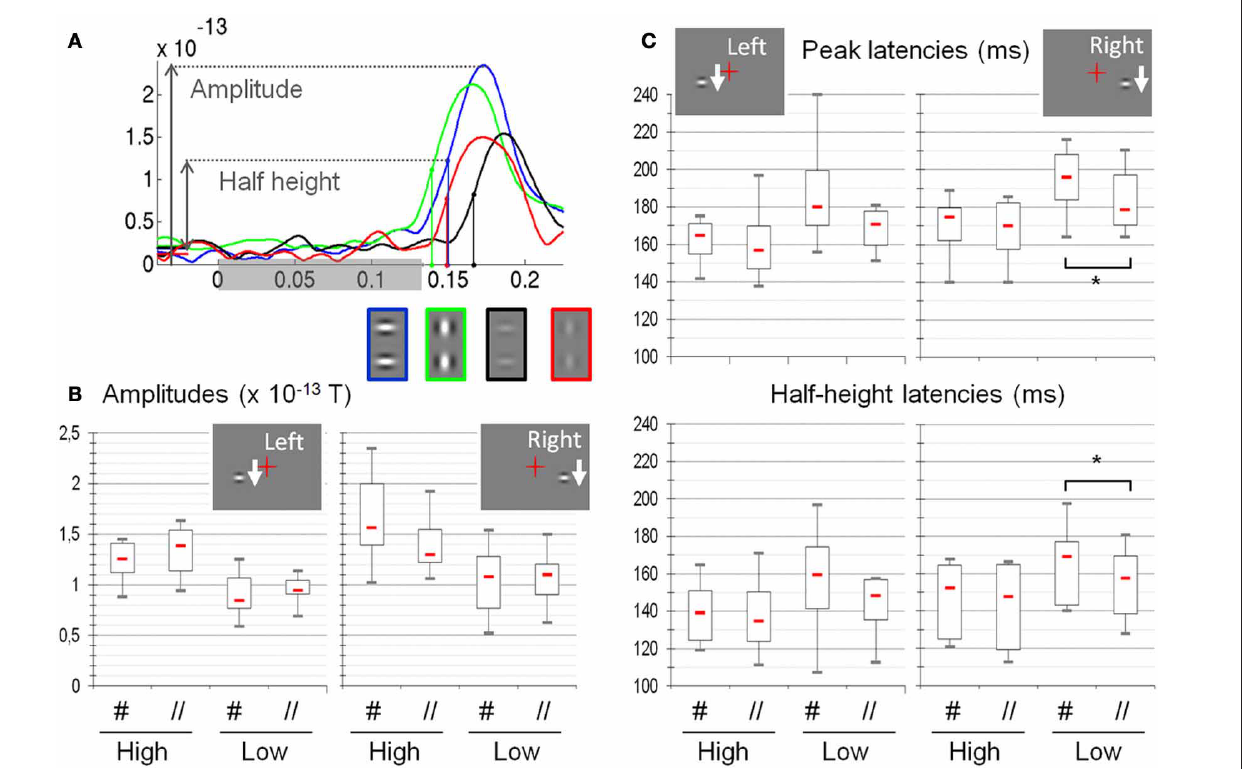
FIGURE 4 | Amplitude, latency and half-height latency measured on the MEG signals as a function of the different experimental conditions ( N = 8).(A) Example of individualtimecourses(subjectS6,responsesto right presentation conditions) averaged over selected sensors. The color of the curve codes for the experimental condition, reminded below (green: High //, blue: High #, red: Low//, black: Low#). The shaded rectangle on the horizontal axis shows the whole period of stimulation. (B) Amplitudes: High-contrast